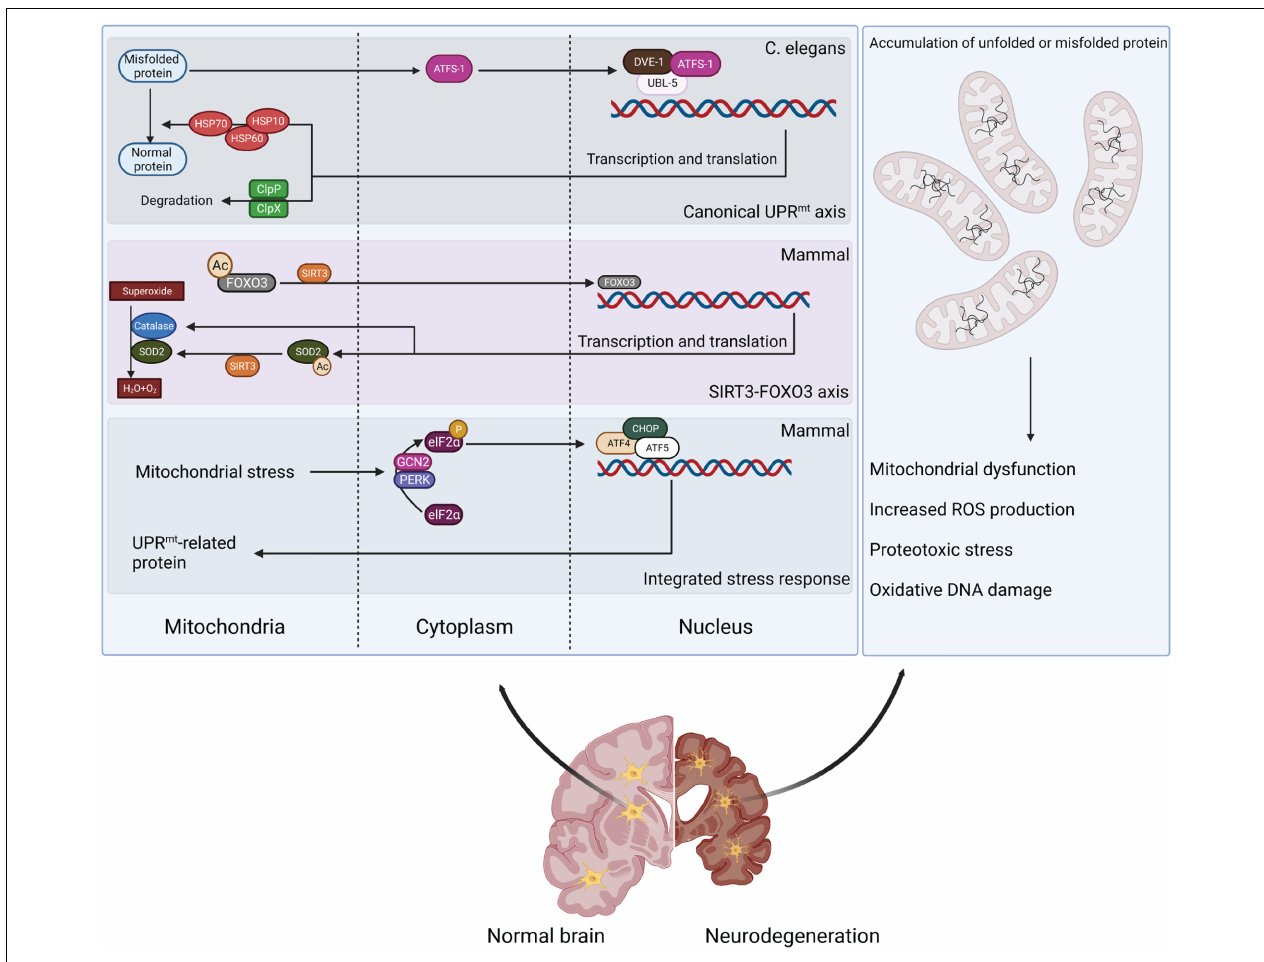
FIGURE 1 | Retrograde signaling between mitochondria and nucleus to alleviate mitochondrial proteo-stress. Mitochondrial stress can stimulate defensive responses through different pathways. Canonical UPR mt activation is mediated by ATFS-1 and transcription co-factors DVE-1/UBL-5 to stimulate expression of mitochondrial chaperones (HSP10/60/70) and proteases (ClpP). Proteo-stress-induced production of mitochondrial ROS activates SIRT3 to deacetylate FOXO3, stimulating antioxidant responses. Mitochondrial stress also triggers ISR by stimulating eIF2 α phosphorylation by GCN2 or PERK and activating ATF4/ATF5/CHOP-induced transcription of UPR mt -related genes. However, mitochondrial stress response is defective in neurodegenerative disease, leading to a disturbance in protein homeostasis and mitochondrial